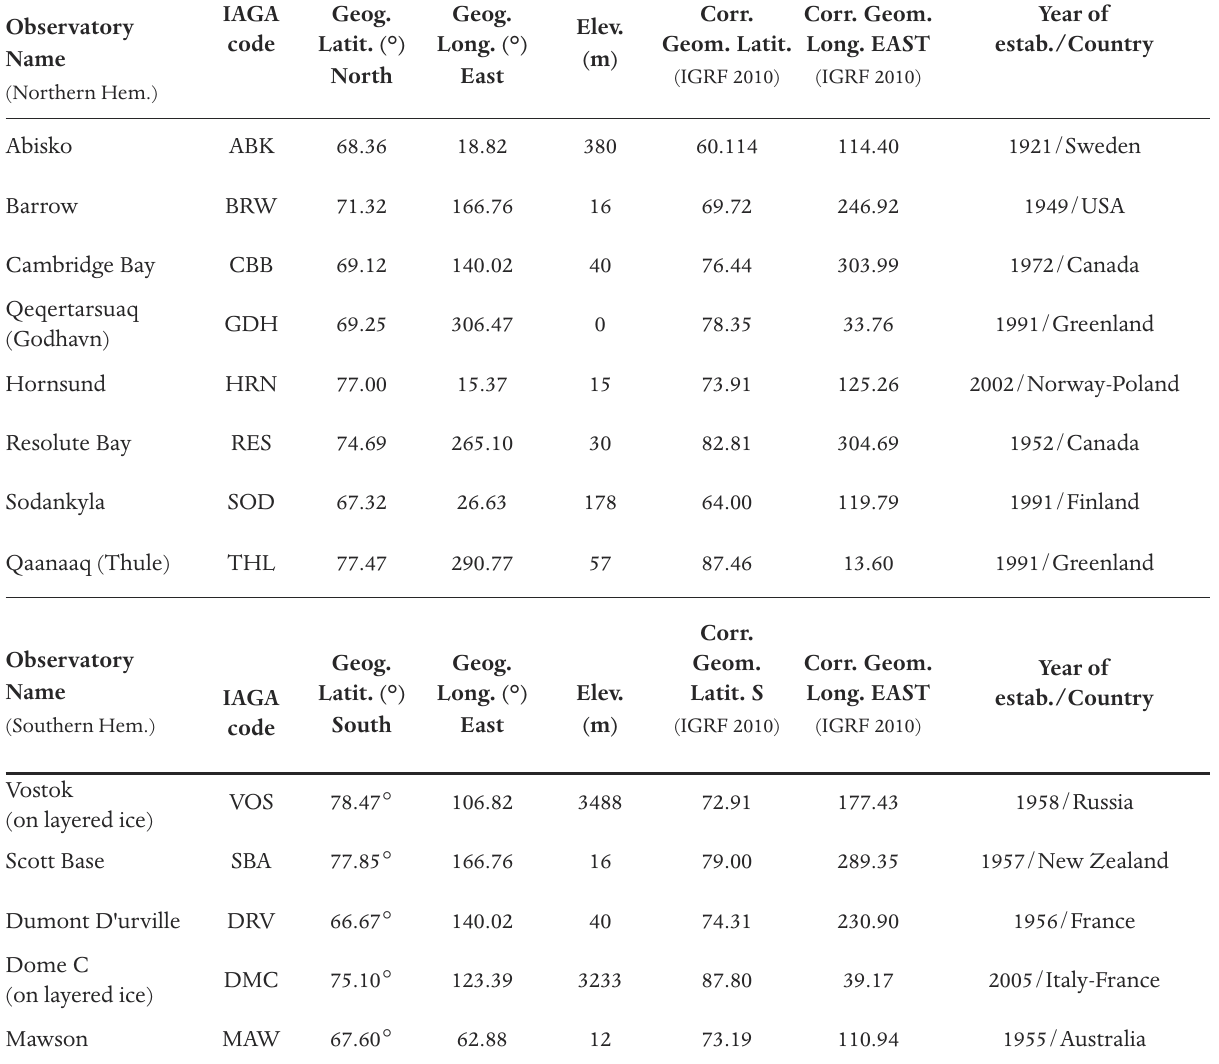
Table 1. List of Intermagnet geomagnetic observatories located northernmost the Arctic Circle (66° 33' 44" N) (top frame) and southern- most the Antarctic Circle (66° 33' 44" S) (bottom frame). Corrected Geomagnetic Coordinates are calculated for the IGRF2010 by the on- line service http://omniweb.gsfc.nasa.gov/vitmo/cgm_vitmo.html. For a visualization of the position of the listed observatories on the world map visit the intermagnet website at the URL address: www.intermagnet.org. Some of these observatories, from opposite polar areas, can be considered as magnetically conjugated, that is they are linked by the same magnetic lines running from an hemisphere to the other. This aspect becomes clear when the geomagnetic coordinate reference system is taken into account. Under this condition many interesting phenomena are reported and studied (e.g. in Lepidi et al.